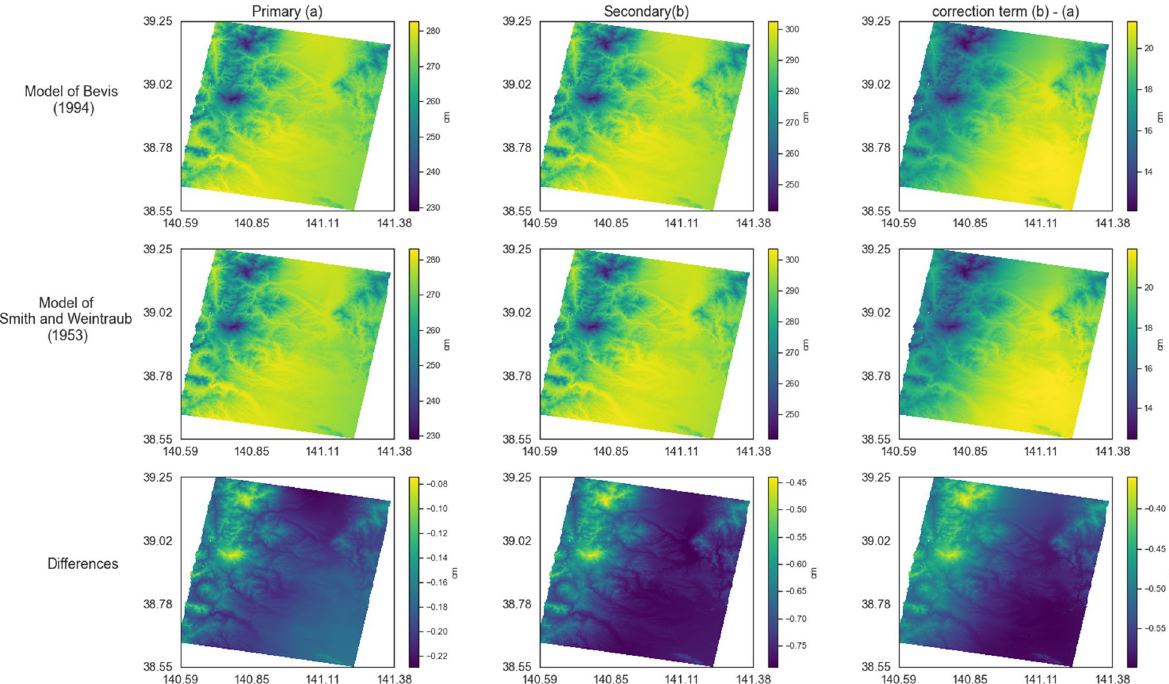
Fig. 4 Examples of tropospheric delay predicted in the Tohoku region obtained using the slant-delay integration method from the refractivity models of Bevis (1994) (top), Smith and Weintraub (1953) (middle), and the differences between the two models (bottom). a Delay predicted for the primary image obtained on 19 May 2016. b Delay predicted for the secondary image obtained on 16 June 2016. c Correction term calculated by the difference in the delay on the two acquisition